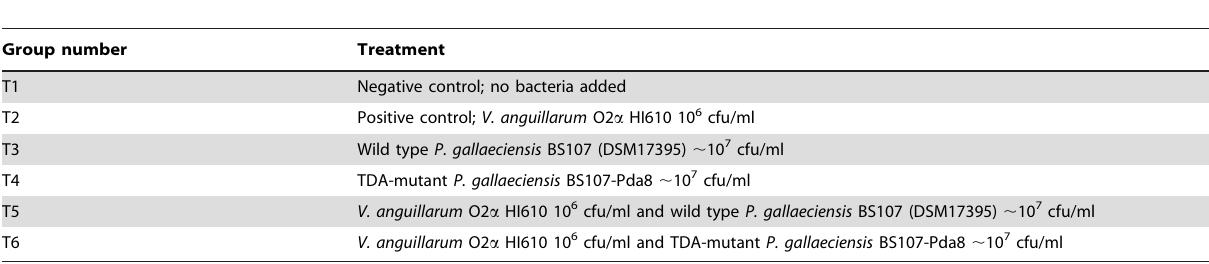
Table 2. Group numbers and treatments in the challenge trial.